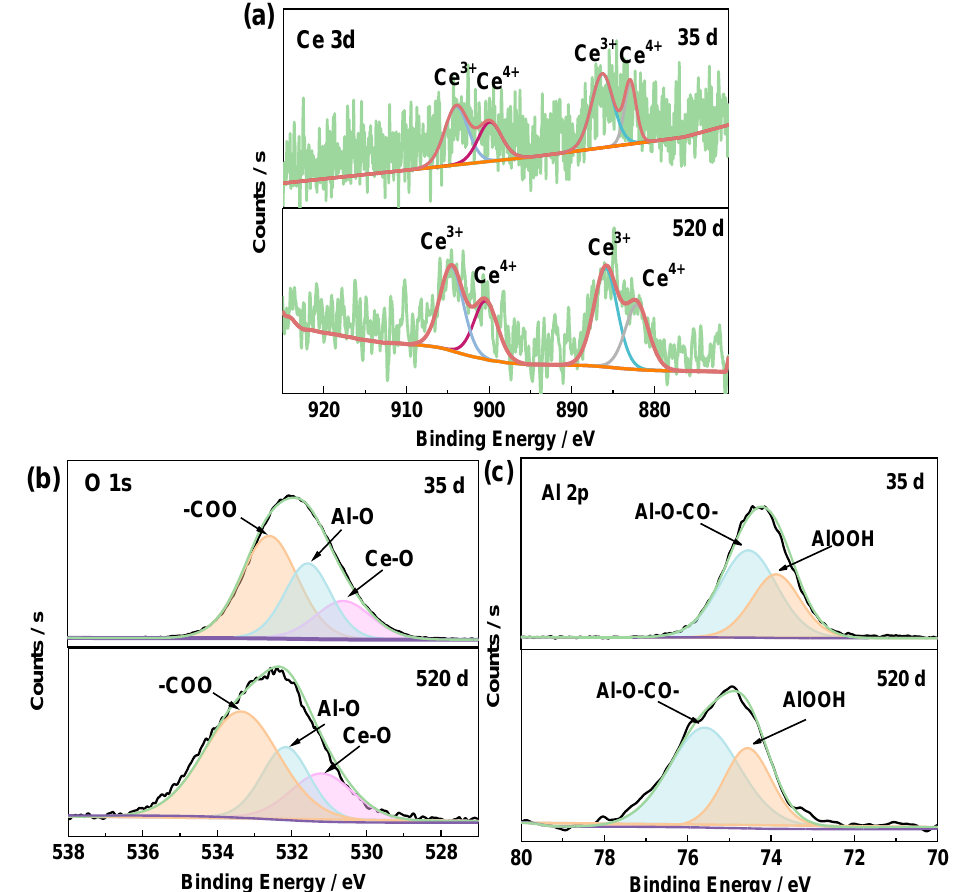
Figure 14. XPS spectra of the substrate surface under double-layer coating immersion in 3.5% NaCl solution for 35 d and 520 d: ( a ) Ce 3d ; ( b ) O 1s; ( c ) Al 2p.